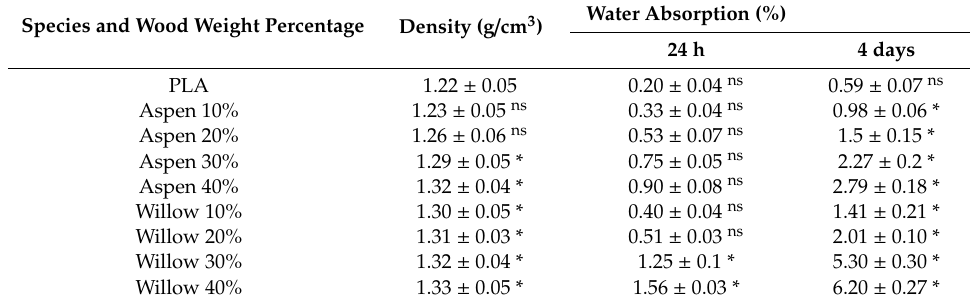
Table 2. Density and water absorption of biocomposites for different weight percentage of wood particles. Species and Wood Weight